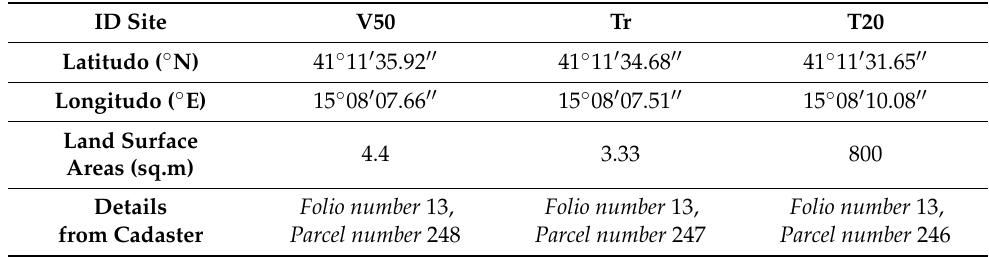
Table 1. Details and description of the plots studied within a flat area situated in the territory of the municipality of Ariano Irpino (Campania region,